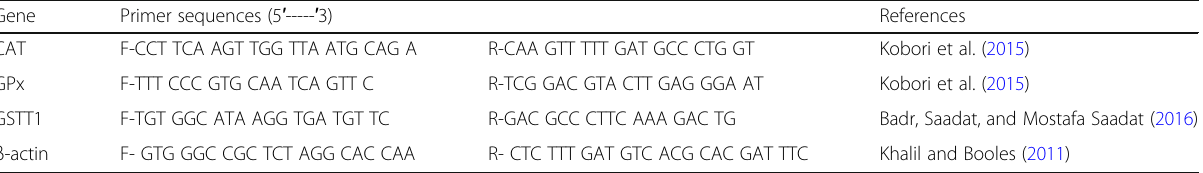
Table 1 Primer used for qRT-PCR amplification Gene Primer sequences (5 ′ ----- ′